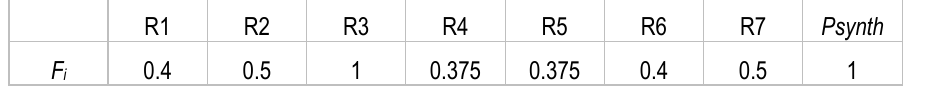
Table 3. Fragility coefficients of the reactions in NetEx with respect to the production of P. R1 R2 R3 R4 R5 R6 R7 Psynth F i 0.4 0.5 1 0.375 0.375 0.4 0.5